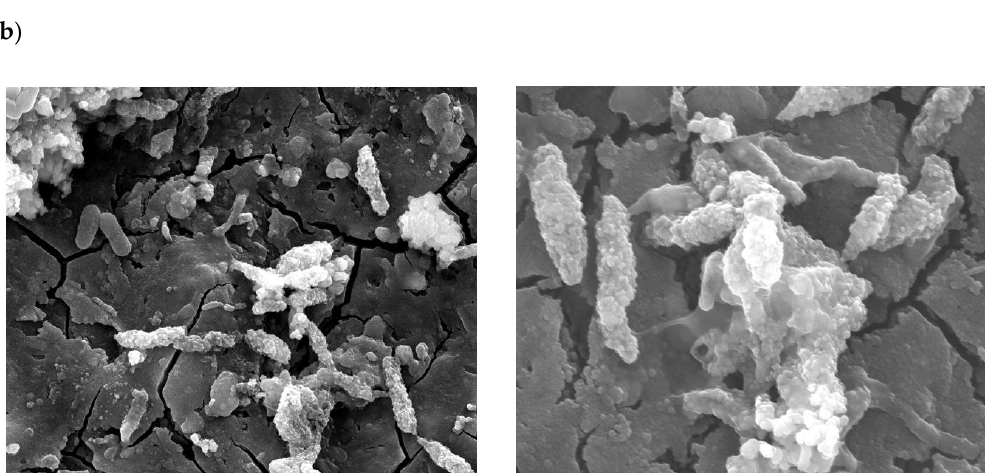
Table 3. The roughness values of analyzed thin films after immersion in SBF.